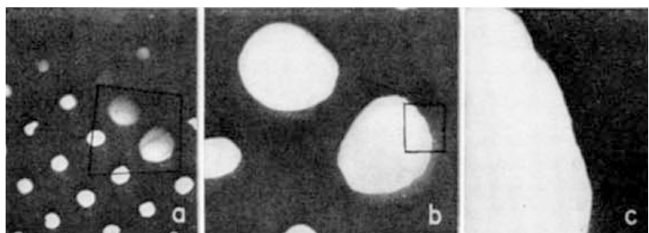
Figure 9. Images of a copper grid obtained by Morton and Ramberg using point projection microscopy (PPM) with electrons, at magnifications of ( a ) 200, ( b ) 600, and ( c ) 3000 times. Figure reprinted from [27], copyright (1939) by the American Physical Society.